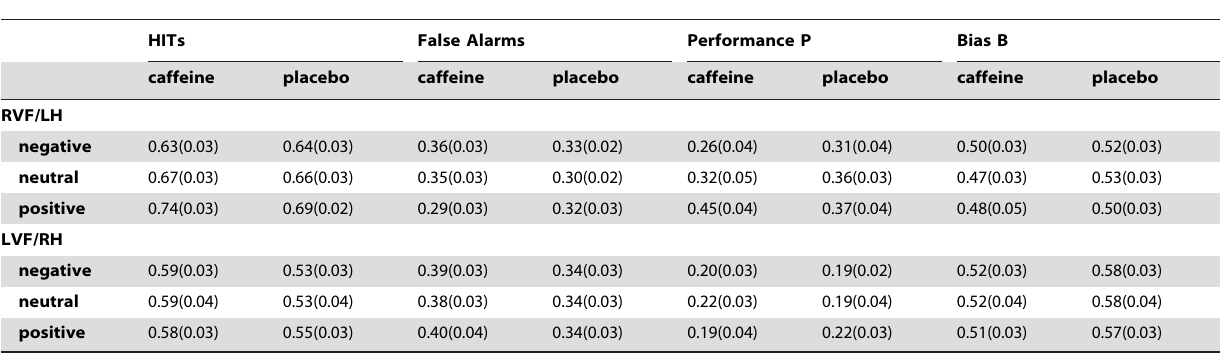
Table 3. Behavioral results. Average data per condition and group.